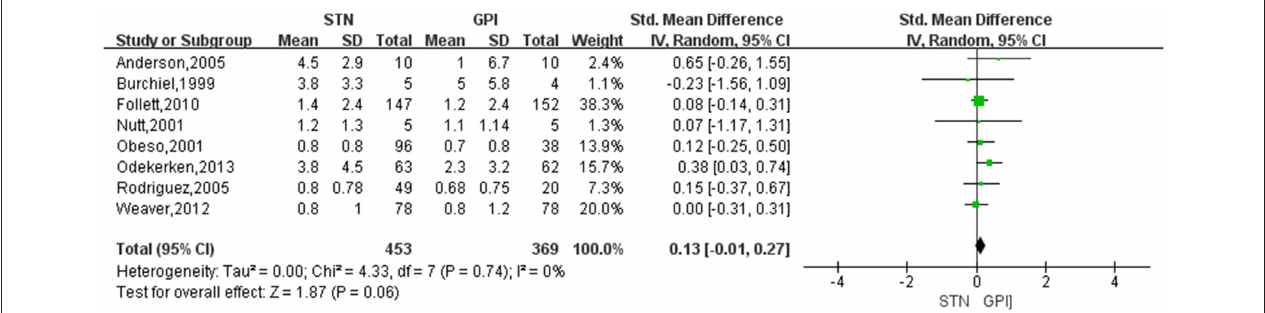
FIGURE 3 | Forest plot of mean difference of dyskinesia score in the on-medication/on-stimulation state between STN DBS and GPi DBS. GPi, globus pallidus interna; STN, subthalamic nucleus; IV, inverse variance; CI, confidence interval; Std, standardized.